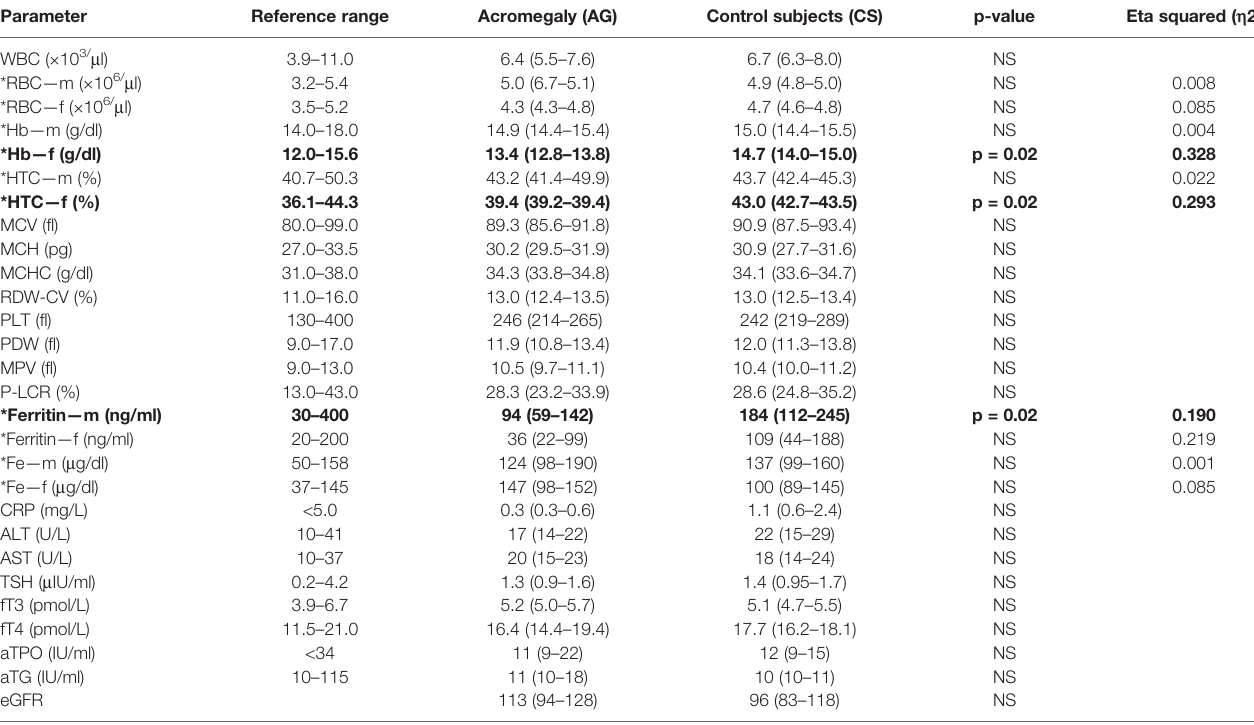
TABLE 2 | Biochemical parameters in patients with AG at the moment of diagnosis compared to CS. Parameter Reference